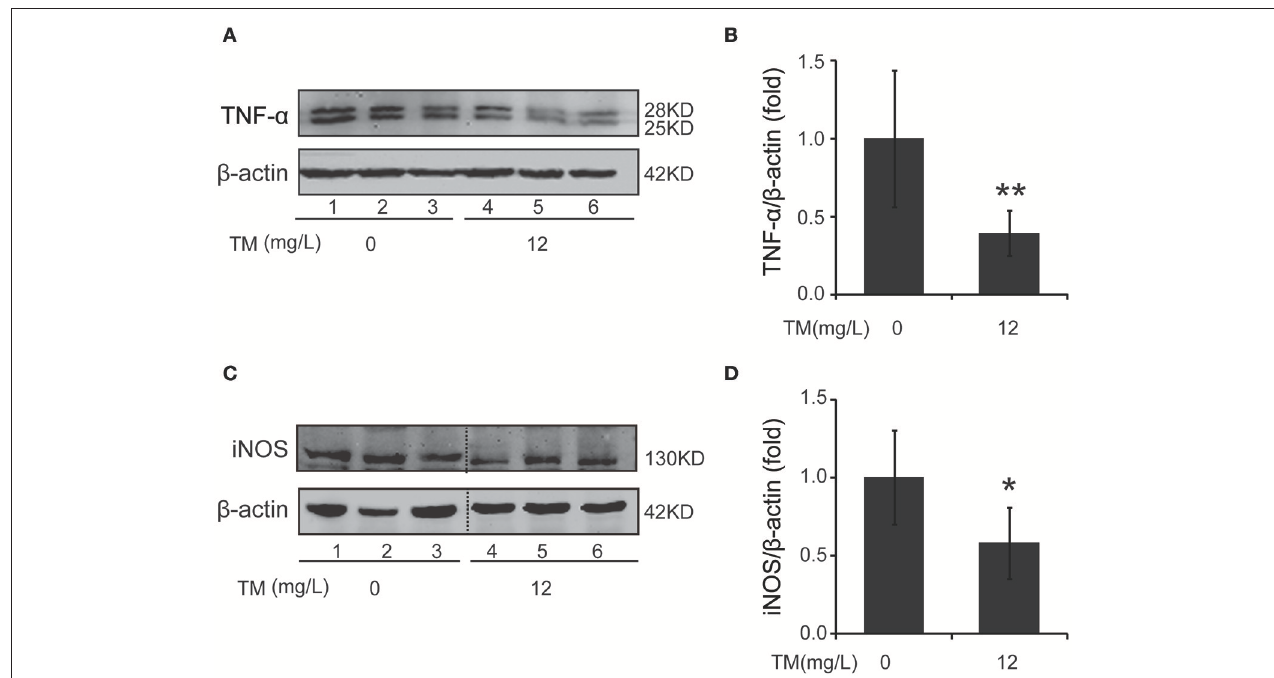
FIGURE 1 | TM leads to suppression of pro-inflammatory cytokines in APP/PS1 Tg mouse brains. APP/PS1 Tg mice were pretreated with TM for 3 months and the brain homogenates were used to analysis the effects of TM on the production of pro-inflammatory cytokines. Lanes 1–3 represented different individuals of control APP/PS1 mice. Lanes 4–6 represented different individuals of TM-treated APP/PS1 mice. (A,B) Immunoblot images (A) and quantifications (B) show that TM reduced the expression of TNF- α . (C,D) Immunoblot images (C) and quantifications (D) show that TM reduced the expression of iNOS. Data are represented as means ± SD . N = 6 mice per group. * p < 0.05, ** p < 0.01. The p -values were calculated using 2-tailed Student’s t